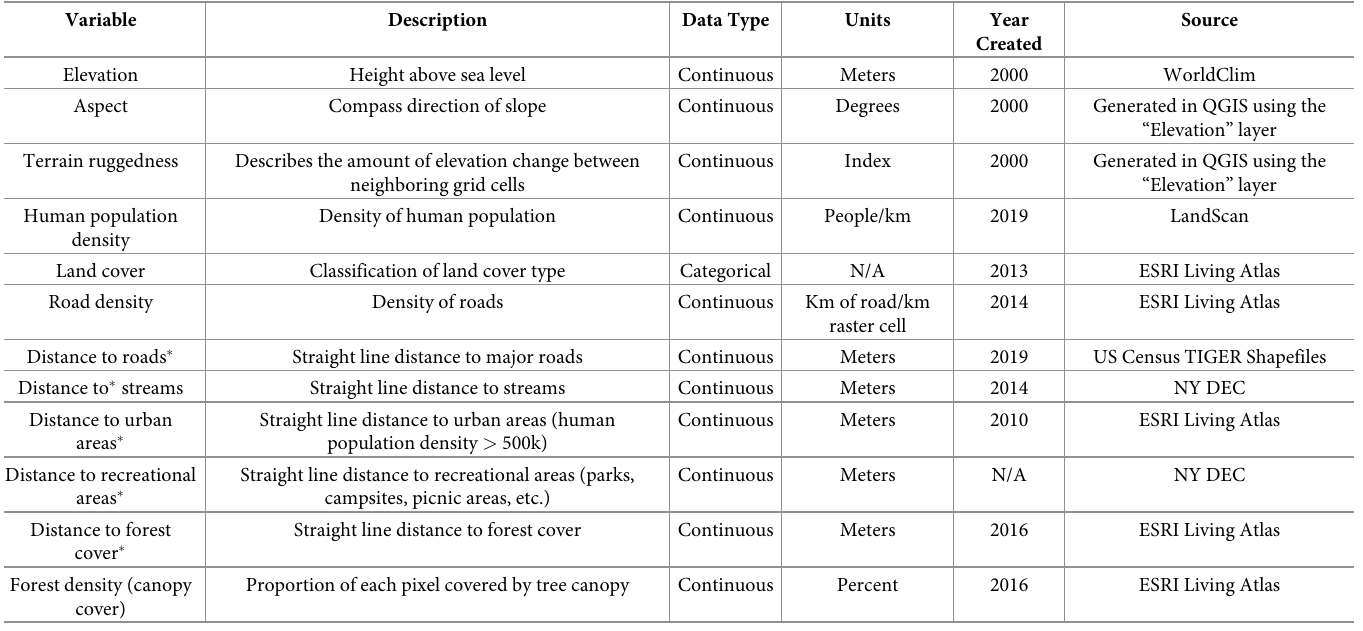
Table 1. Description of the environmental, landscape, and anthropogenic variables used to model human-black bear conflicts in the